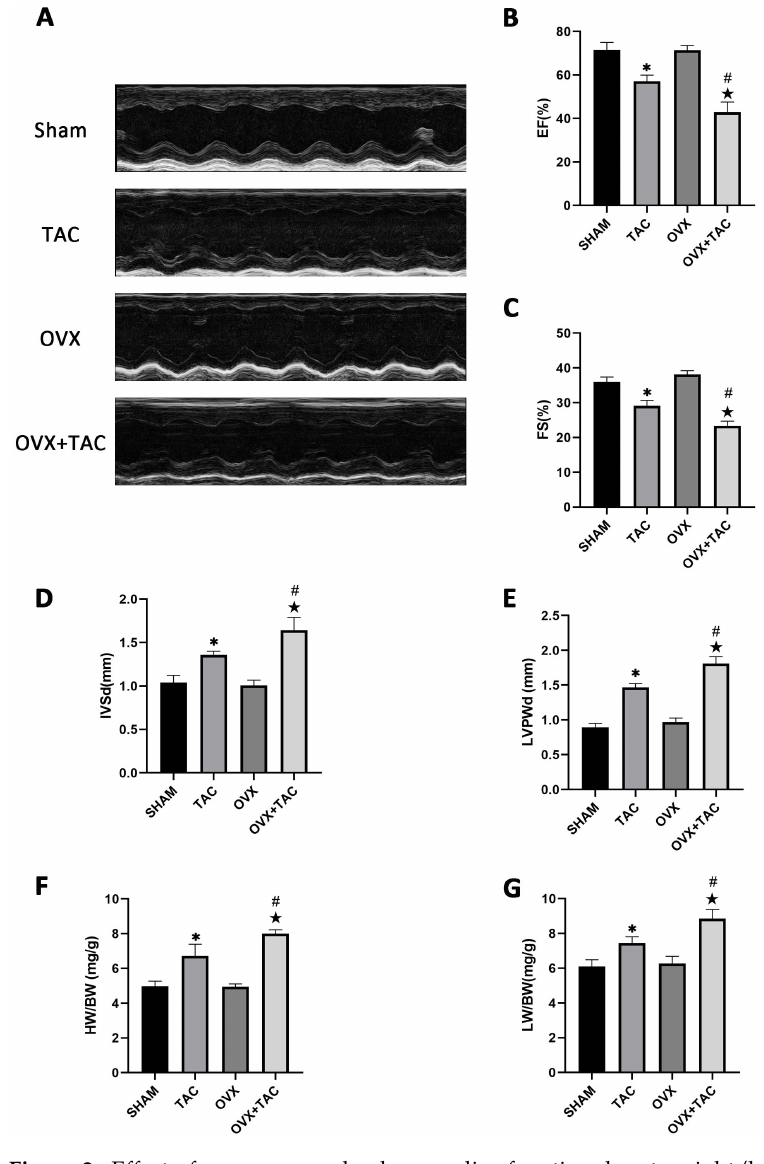
Figure 2. Effect of pressure overload on cardiac function, heart weight/body weight (HW/BW) and lung weight/body weight (LW/BW) after 8 weeks of TAC by M-mode echocardiography. ( A ) Representative images of M-mode echocardiography in different groups. ( B ) Ejection fraction (EF). ( C ) Fraction shortening (FS). ( D ) Interventricular septal thickness at end diastole (IVSd). ( E ) Left ventricular posterior wall thickness at end diastole (LVPWd). ( F ) HB/BW. ( G ) LW/BW. The data is expressed as mean ± SEM and analyzed by one-way ANOVA (n = 4). * p < 0.05 vs. Sham; # p < 0.05 vs. TAC; (cid:70) p < 0.05 vs.